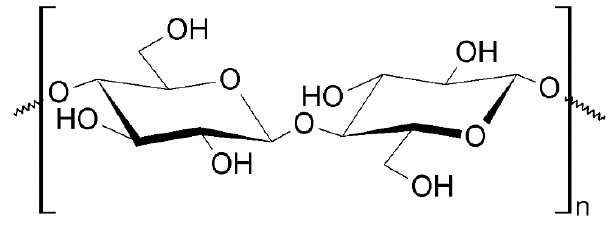
Figure 23. Structure of cellulose pristine bionanomolecules.